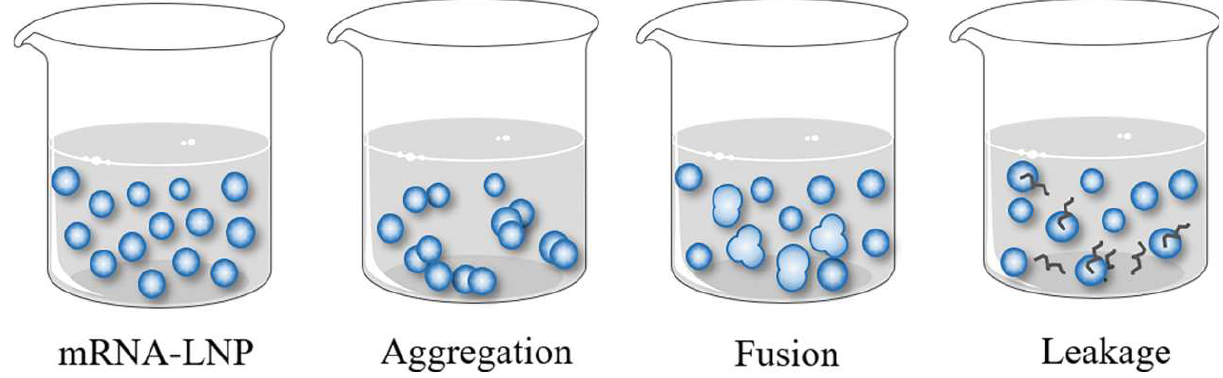
Figure 6. Physical instability mechanisms of mRNA–LNPs.